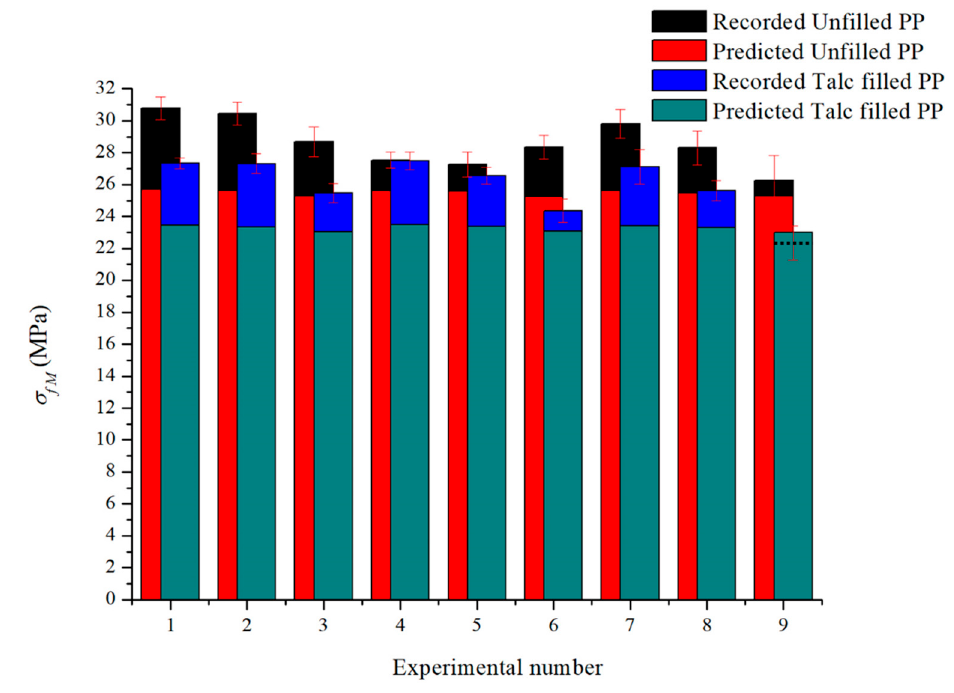
Figure 4. Recorded and predicted Maximum Flexural Strength for both polymers.